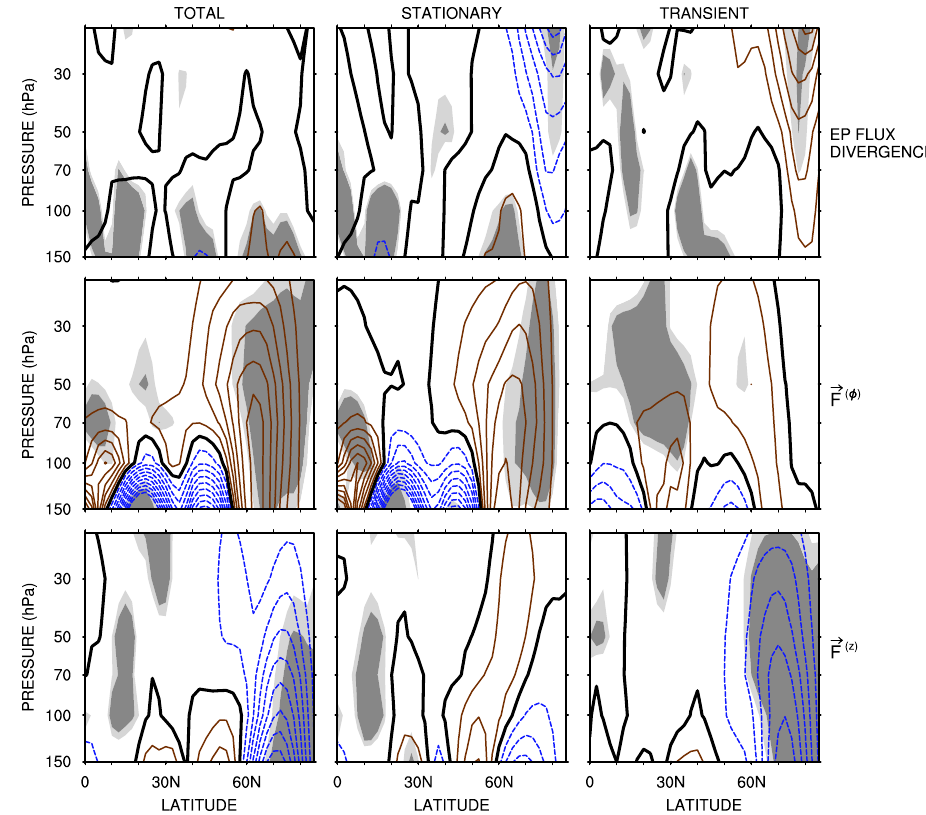
Fig. 12. Same as Fig. 11 but for the R-2